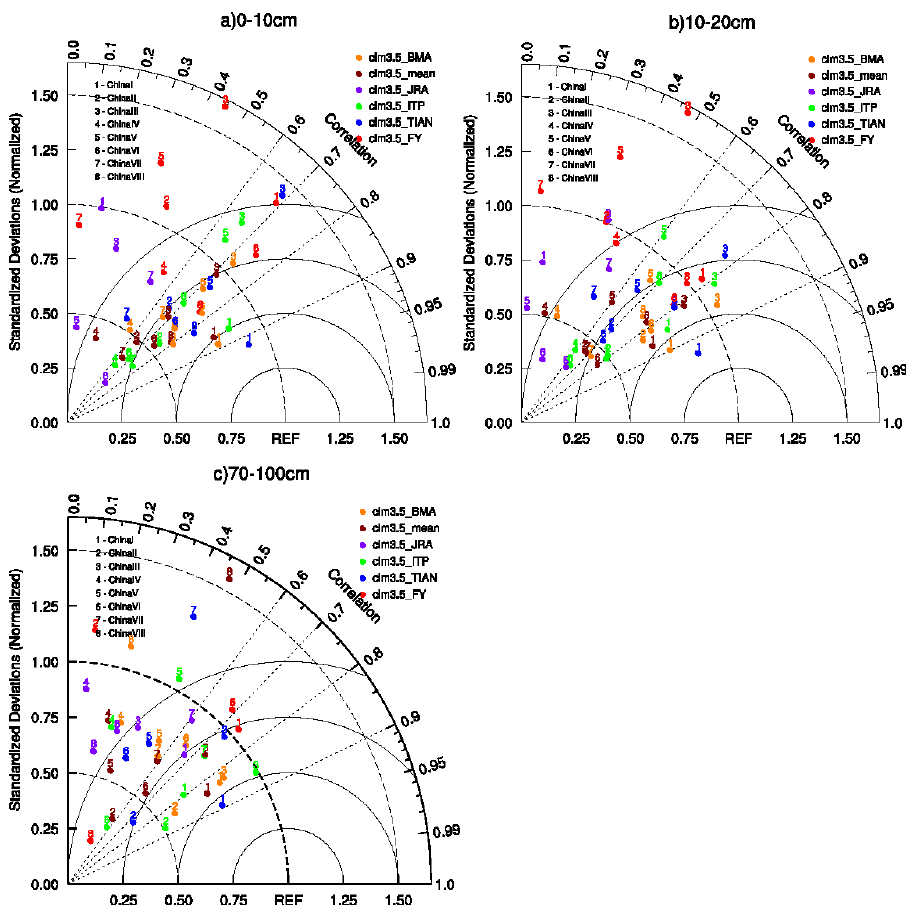
Fig.9. Taylor diagram illustrating the comparison between CLM3.5_FY, CLM3.5_ 725 Fig. 9. Taylor diagram illustrating the comparison between CLM3.5 FY, CLM3.5 TIAN, CLM3.5 ITP, CLM3.5 JRA, CLM3.5 mean, CLM3.5 BMA and in situ observation in the eight subregions of China defined in Table 1 for the validation period July 2008–June 2010 in: (a) 0–10cm soil layer; (b) 10–20cm soil layer; (c) 70–100cm soil TIAN, CLM3.5_ITP, CLM3.5_JRA, CLM3.5_mean, CLM3.5_BMA and in situ 726